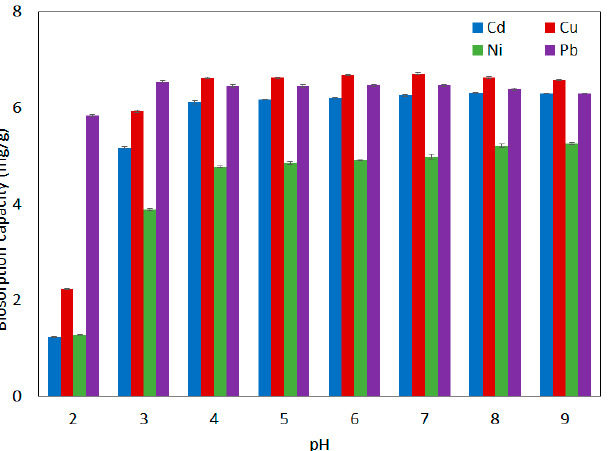
Figure 7. Effect of pH on Cd 2+ , Cu 2+ , Ni 2+ , and Pb 2+ sorption capacity of 1 M NaOH-treated H. fusiformis.